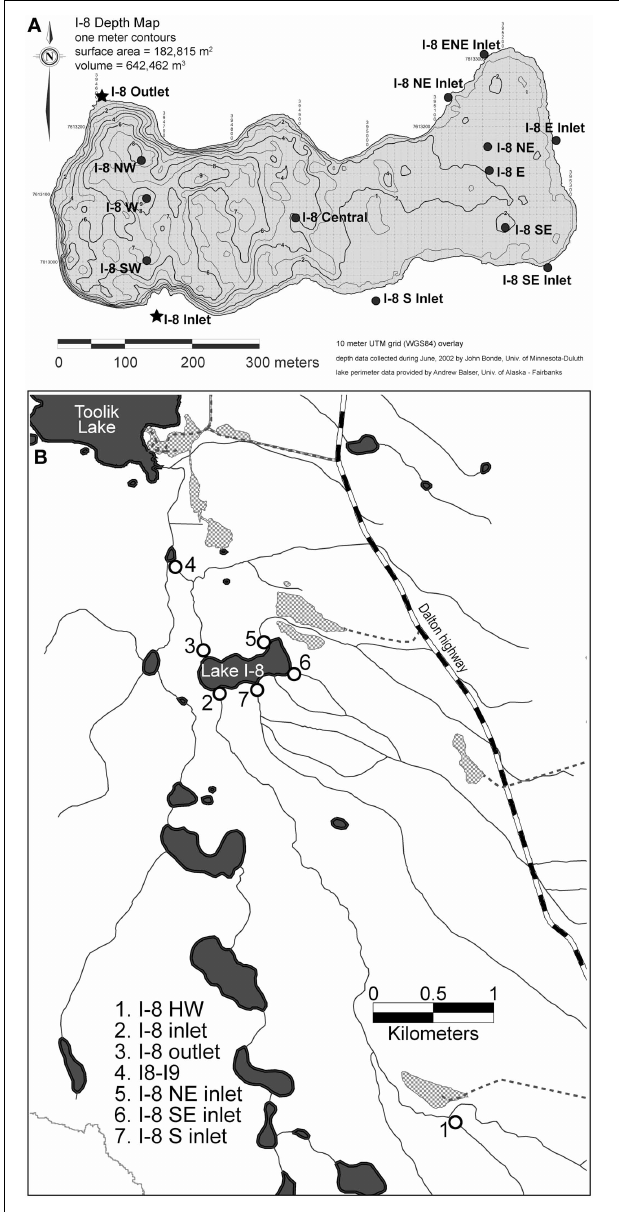
FIGURE 1 | (A) Lake spatial sampling sites at Lake I-8, Northern Alaska. I-8 outlet is located at 394605.858 Easting 7613243.017 Northing on the UTM Zone 6 North, WGS84 coordinate system (149.59 ◦ W, 68.61 ◦ N). (B) Sampling locations in the I-series catchment to Toolik Lake,